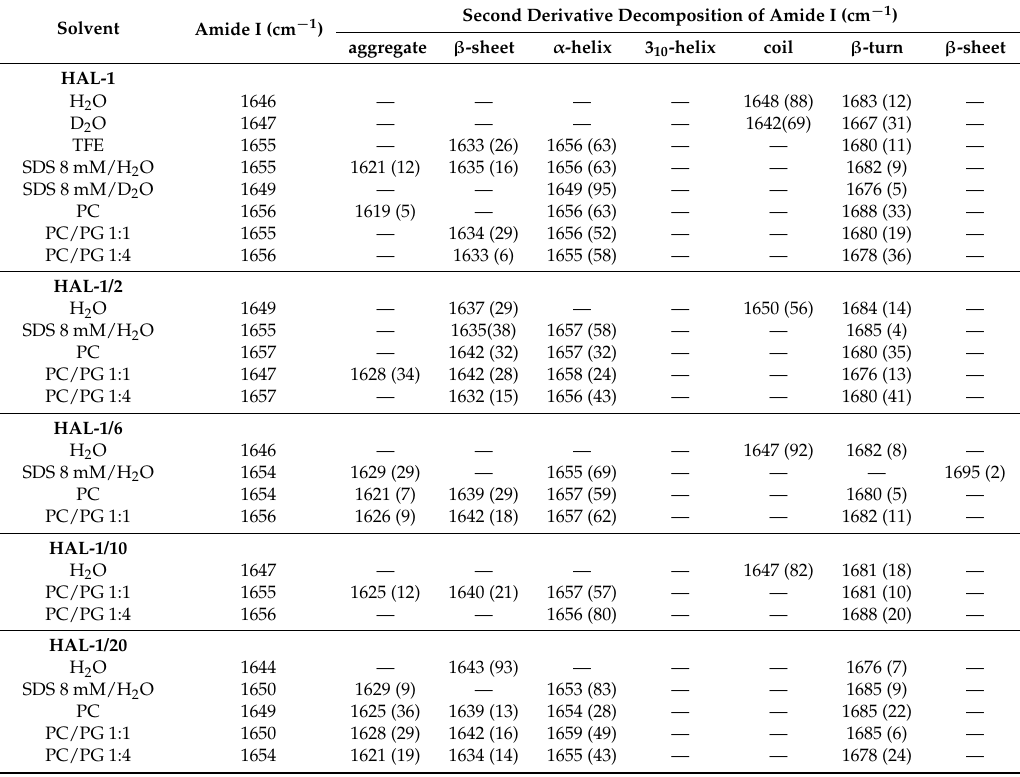
Table A4. Estimation of the secondary structure content from IR spectra, using a bandfitting procedure for HAL-1 and its analogs in aqueous solution (H 2 O and D 2 O), in the presence of SDS, TFE, and LUVs. The numbers in parentheses correspond to percentages of each fitted band in the amide I